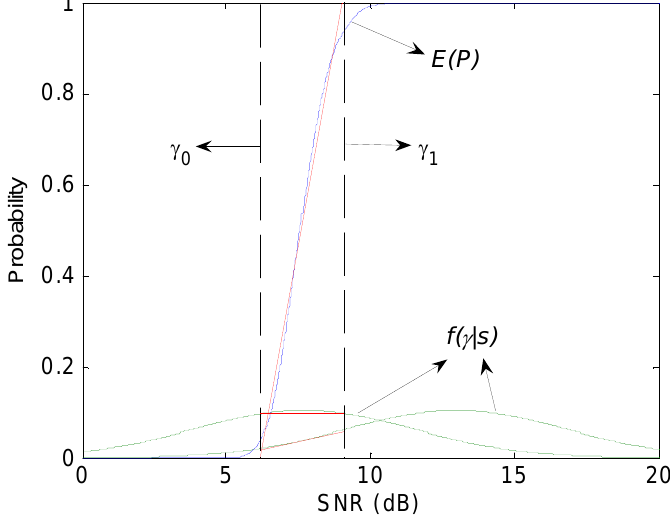
Figure 4. The procedure of linear approximation for Ψ ( γ ) and f ( γ | s